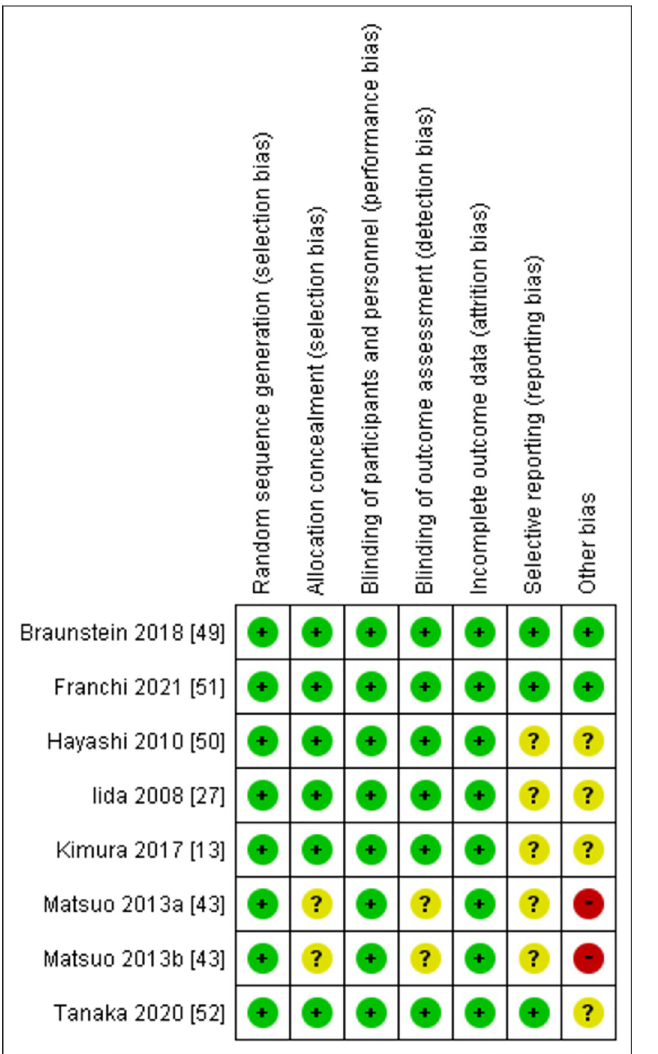
Fig 3. Risk of bias summary for each included